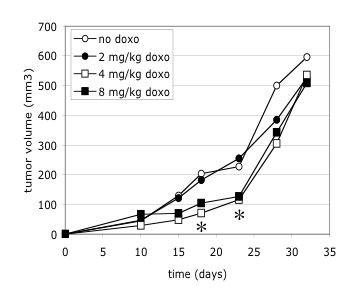
The effect of doxorubicin on growth of PC3 xenografts. Athymic nude mice were injected with PC3 cells (day 0) and treated with doxorubicin (i.p.) on day 10. Tumor size in animals treated with 4 or 8 mg/kg doxorubicin were significantly different from the untreated group on day 18 and 22, P < 0.05.